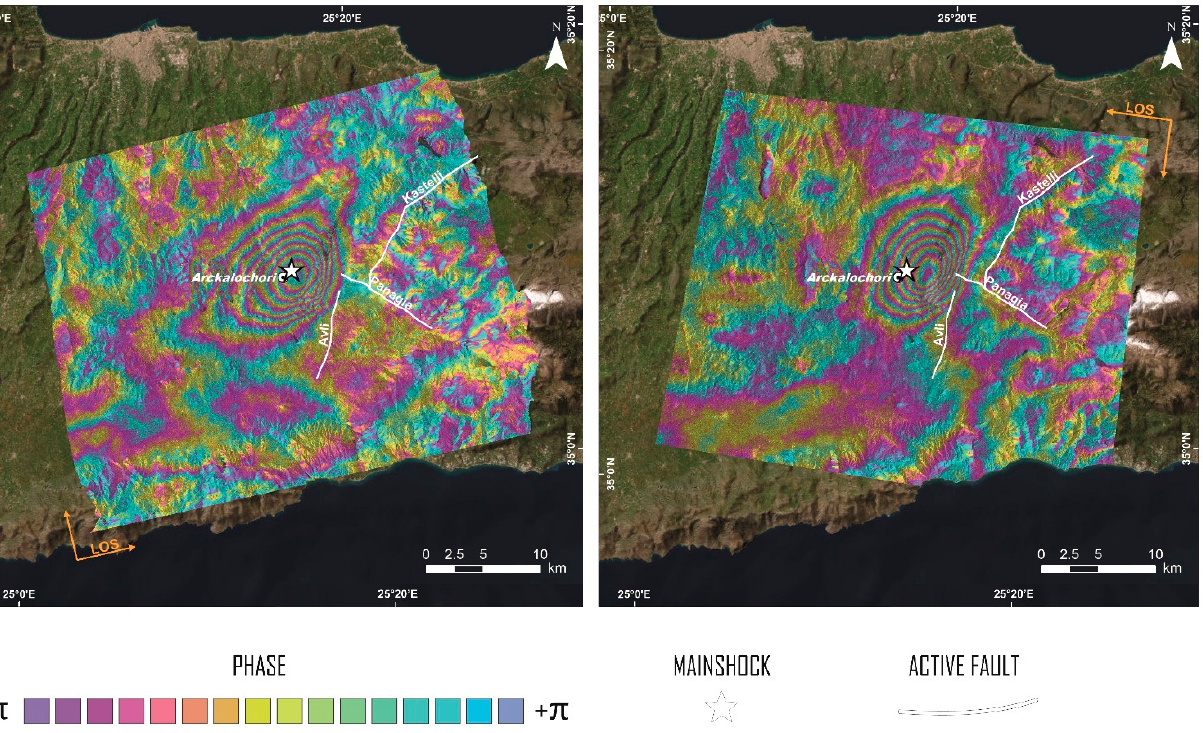
Figure 3. Ascending ( left ) and descending ( right ) wrapped interferograms of the 2021 M 5.8 Heraklion earthquake.